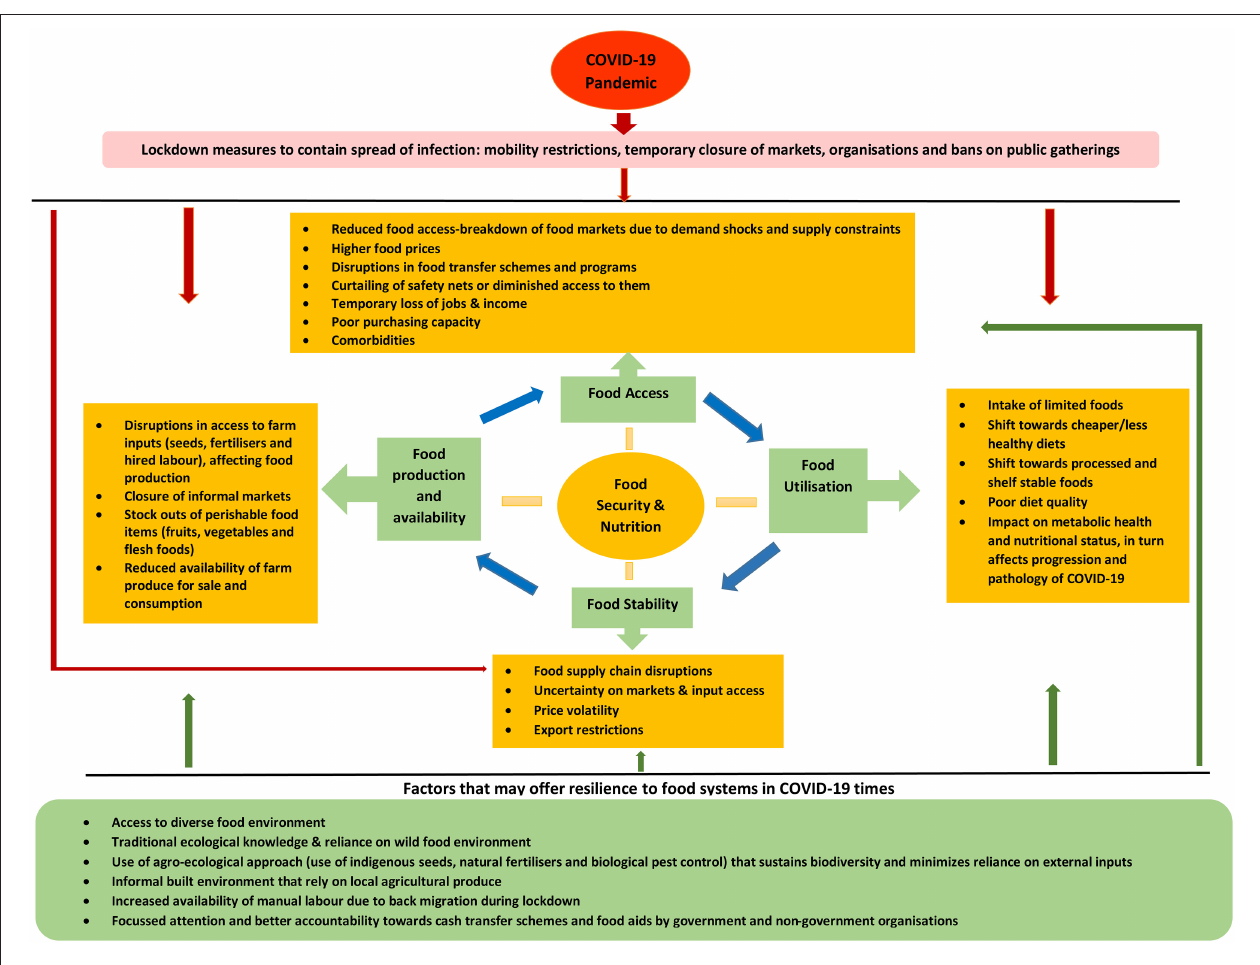
FIGURE 3 | Conceptual framework: Impact of COVID-19 pandemic on food security among vulnerable populations and factors offering